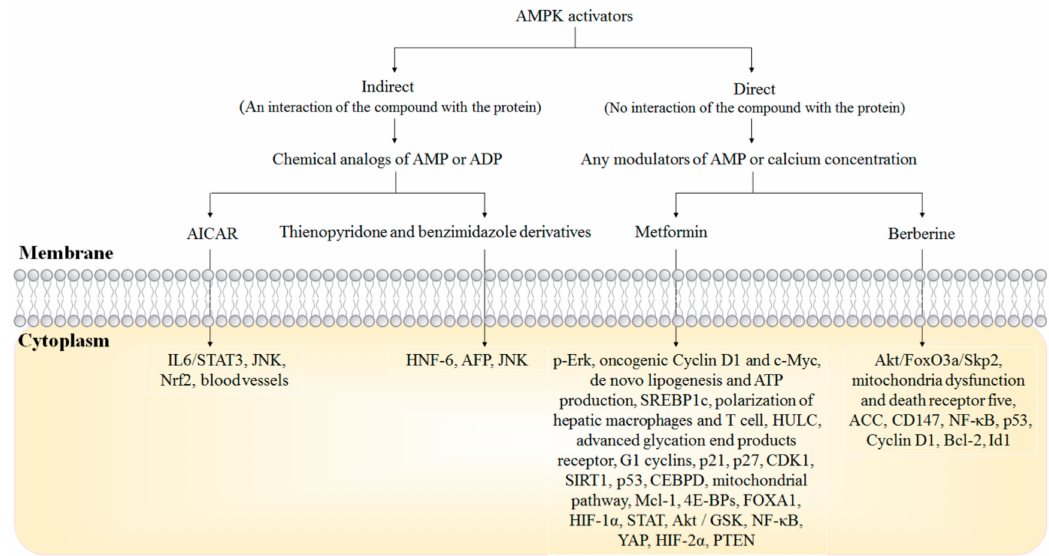
Figure 2. The schematic of AMPK activators regulate Hepatocellular Carcinoma (HCC)